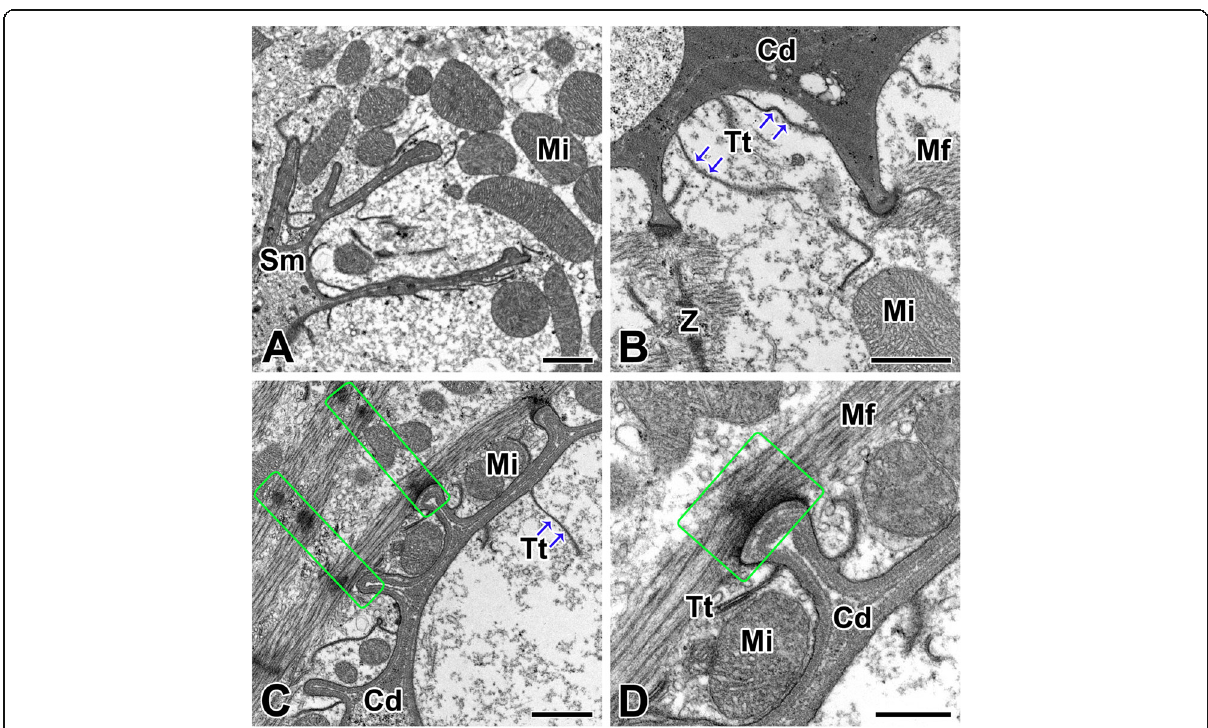
Fig. 5 Transmission electron micrographs of the sarcolemma and its cardiac junctions in the spider L. mactans. a : Sarcolemma (Sm) of the cardiac muscle is composed of two dense membranes separated by a relatively clear space. b : Intercalated disc (Cd) shows deep invagination of sarcolemma to increase its surface area. c : Intercalated disc shows a Z-line (Z) connection to sarcolemma (rectangles) and T-tubules (Tt). d : Both of adherens junctions (rectangle) are observed in the sarcolemma of the intercalated disc. Mf: myofibril, Mi: motochondria. Scale bars indicate 1 μ m (A-C) and 0.5 μ m (D),